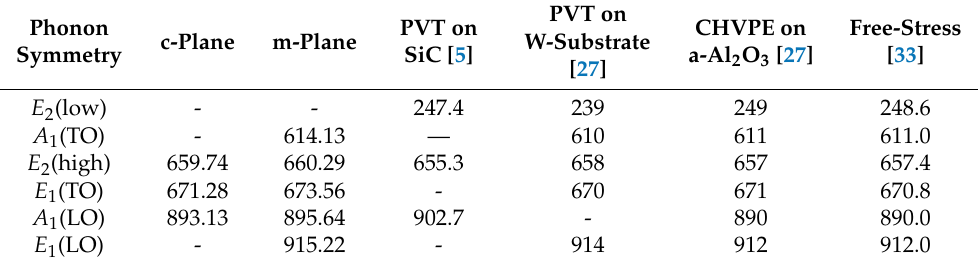
Table 1. Raman phonon energies (cm − 1 ) of the prepared AlN seeds.